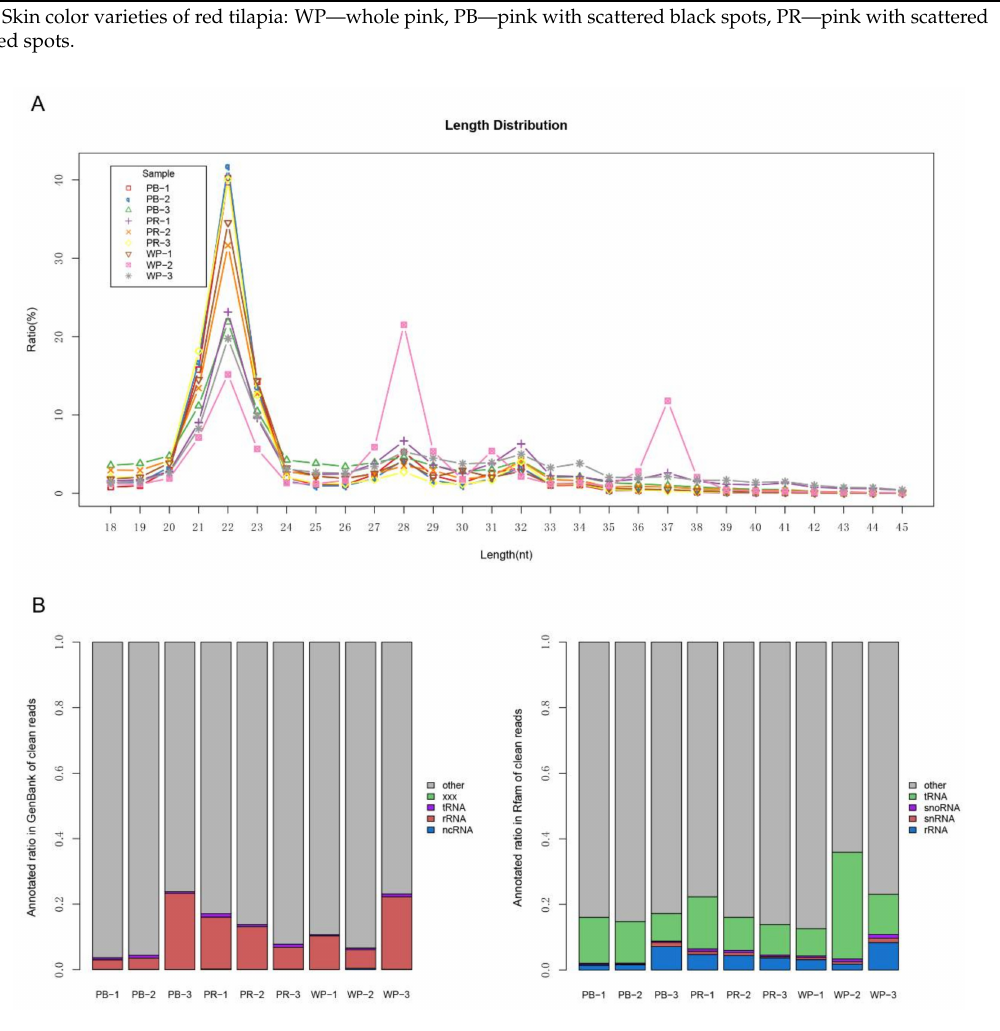
Figure 1. Overview of small RNA library sequencing. ( A ) Length distribution of small RNAs in red tilapia; ( B ) the clean reads were blasted against the GenBank and Rfam databases to annotate rRNA, tRNA, snRNA or